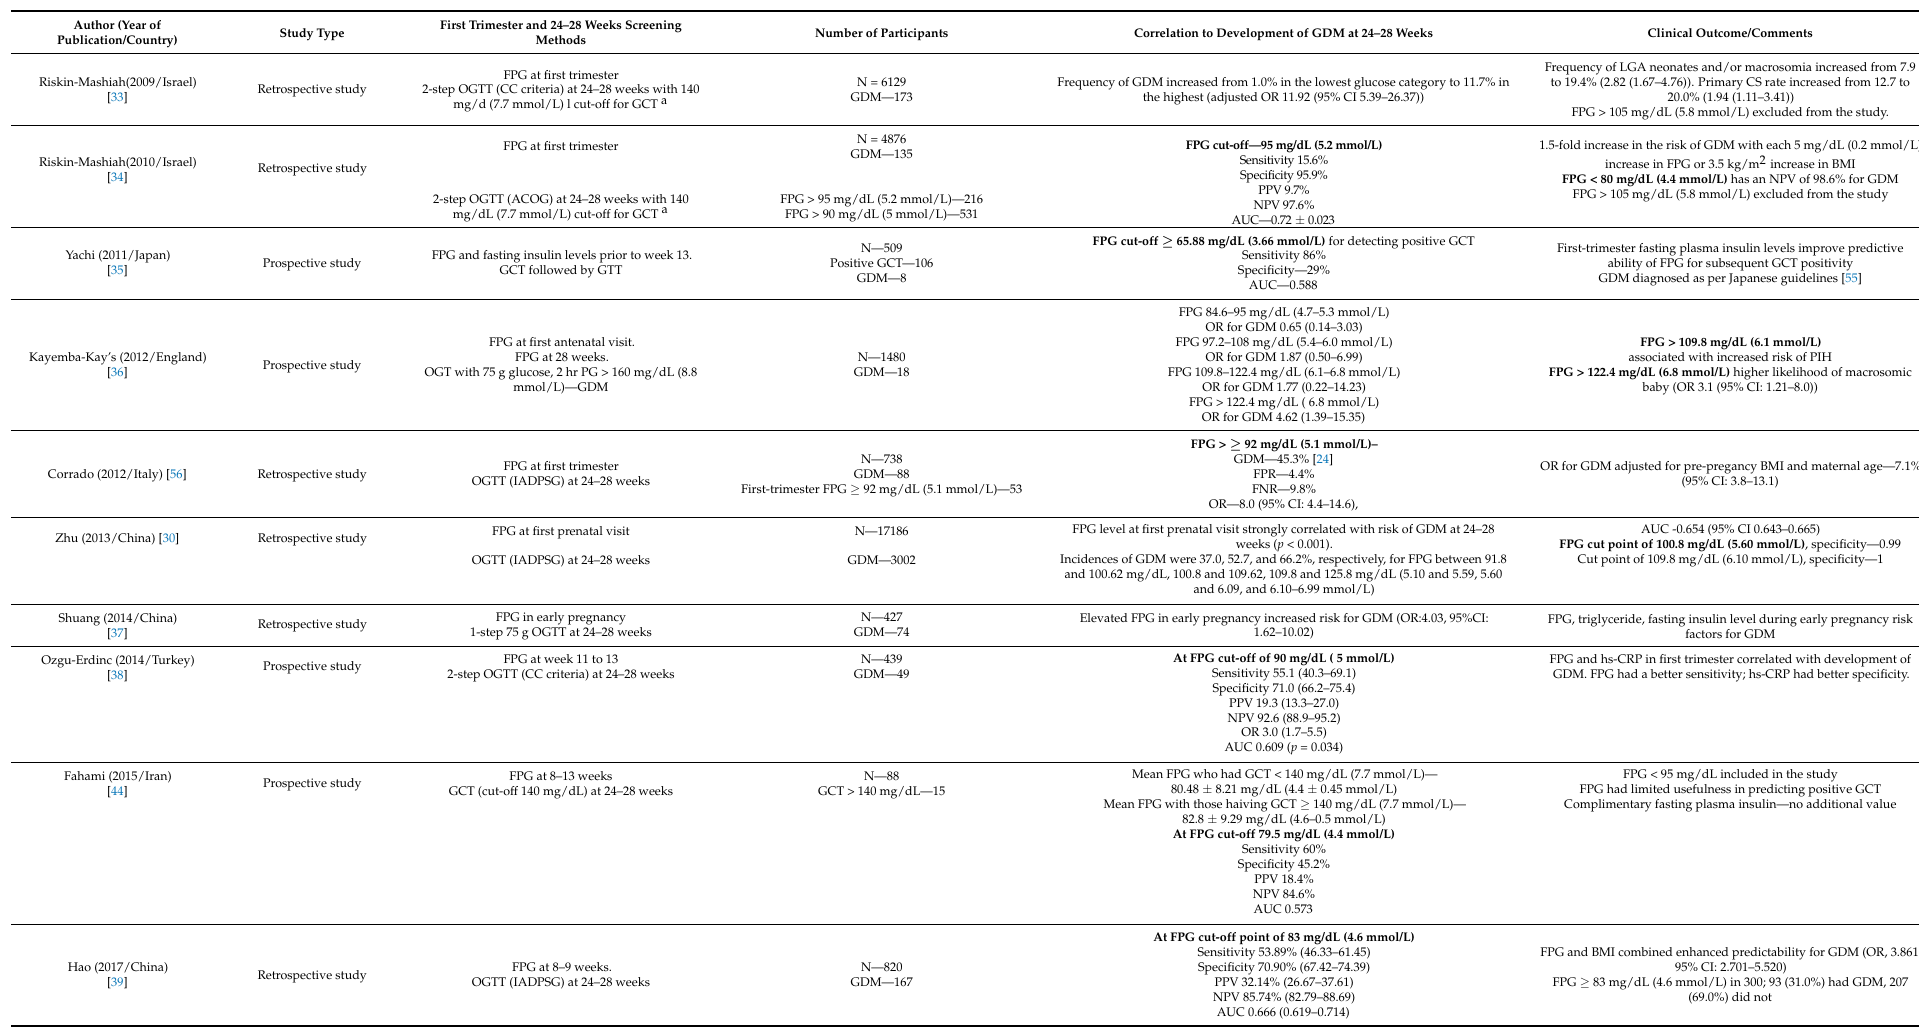
Table 3. Major observational studies (from 2009) analyzing the association between early pregnancy FPG to development of subsequent GDM and perinatal